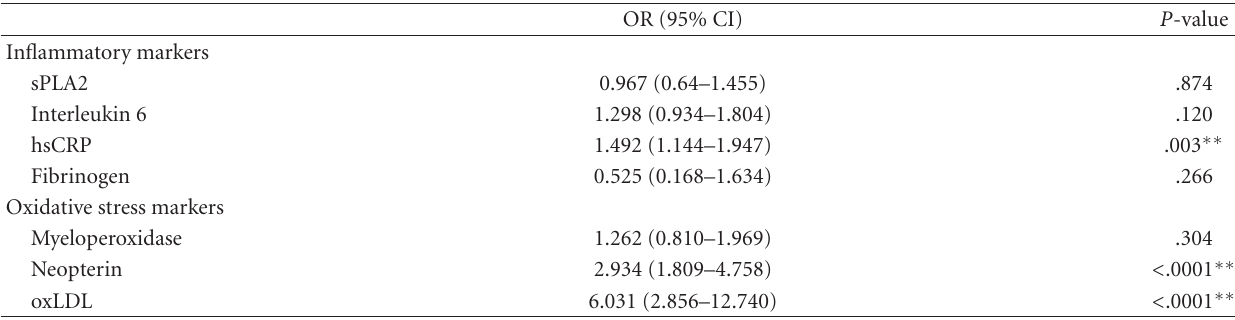
(a) Multinominal regression analysis: Odds ratio and 95% CI for inflammatory and oxidative stress markers for subjects with and without MetS